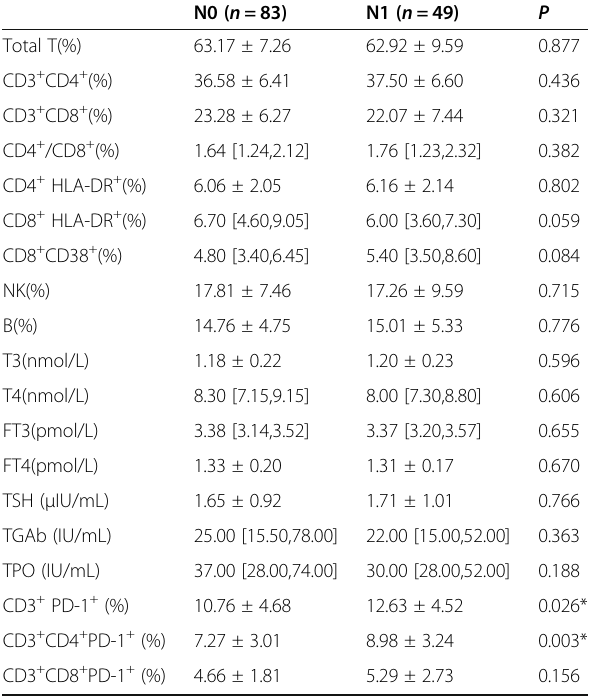
Table 4 Correlation between lymphocyte subsets, thyroid function index and lymph node metastasis of PTC patients